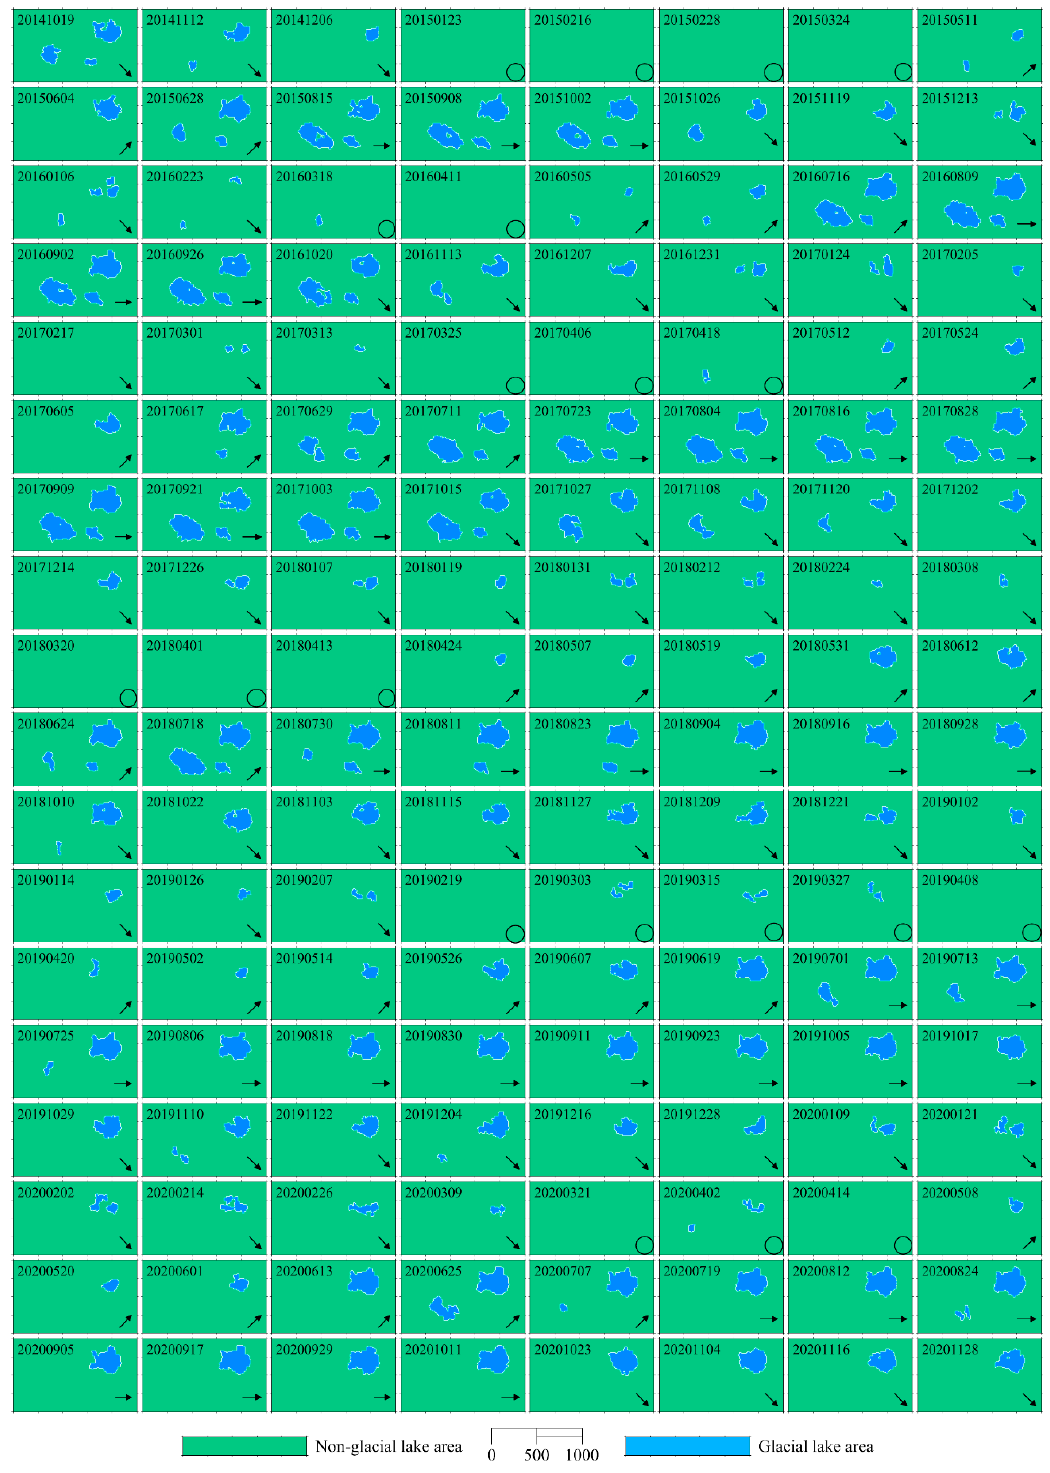
Figure 7. The results after the classification of glacial lakes corresponding to the 144 ratio maps shown in Figure 6, noting that the extracted boundaries are superimposed in each subgraph as the white outlines. The region colored in green represents the non-glacial lake area, while blue represents the glacial lake area. The upper left corner of each sub-figure shows the date when the corresponding SAR image was acquired, in the format of “yyyymmdd”. The lower right corner of each sub-figure is marked with its dynamic status in the cycle. ↗ and ↘ indicate that it is filling and discharging, → and ○ indicating it is dynamically stable and completely drained.